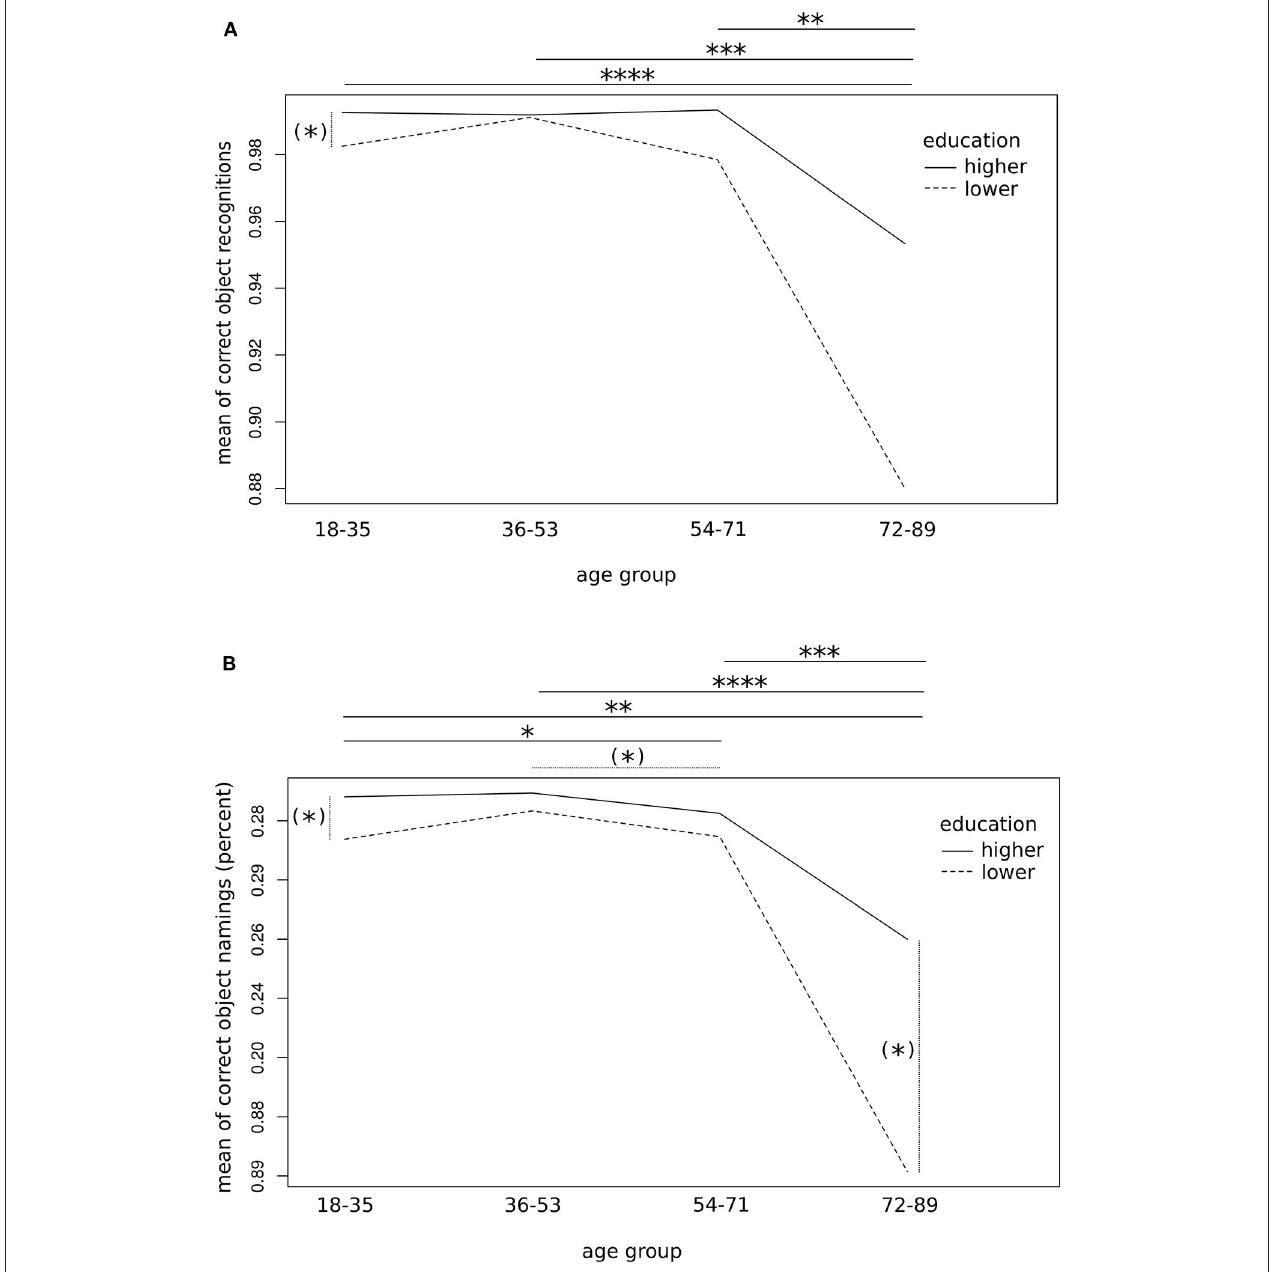
FIGURE 3 | Influence of age group on object naming performance. Interaction plots showing average correctness of object recognition (A) and naming (B) by age groups and education level (i.e., with/without university admission diploma or equivalent). Pooled data of both runs per 100 trials are provided. Significant differences according to groupwise post-hoc comparison of means followed by FDR correction are indicated by asterisks [(*) p < 0.1; * p < 0.05; ** p < 0.01, *** p < 0.001, **** p < 0.0001]. Please note the limited ranges of the y -axis, for better